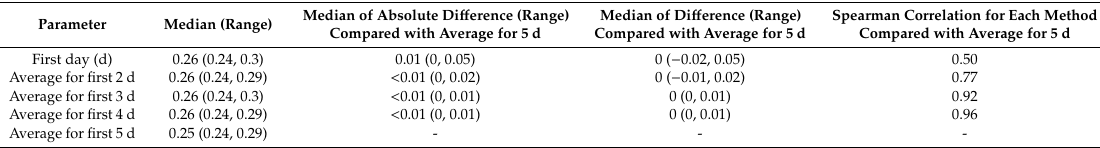
Table 3. Average values for the duration of leg movement.